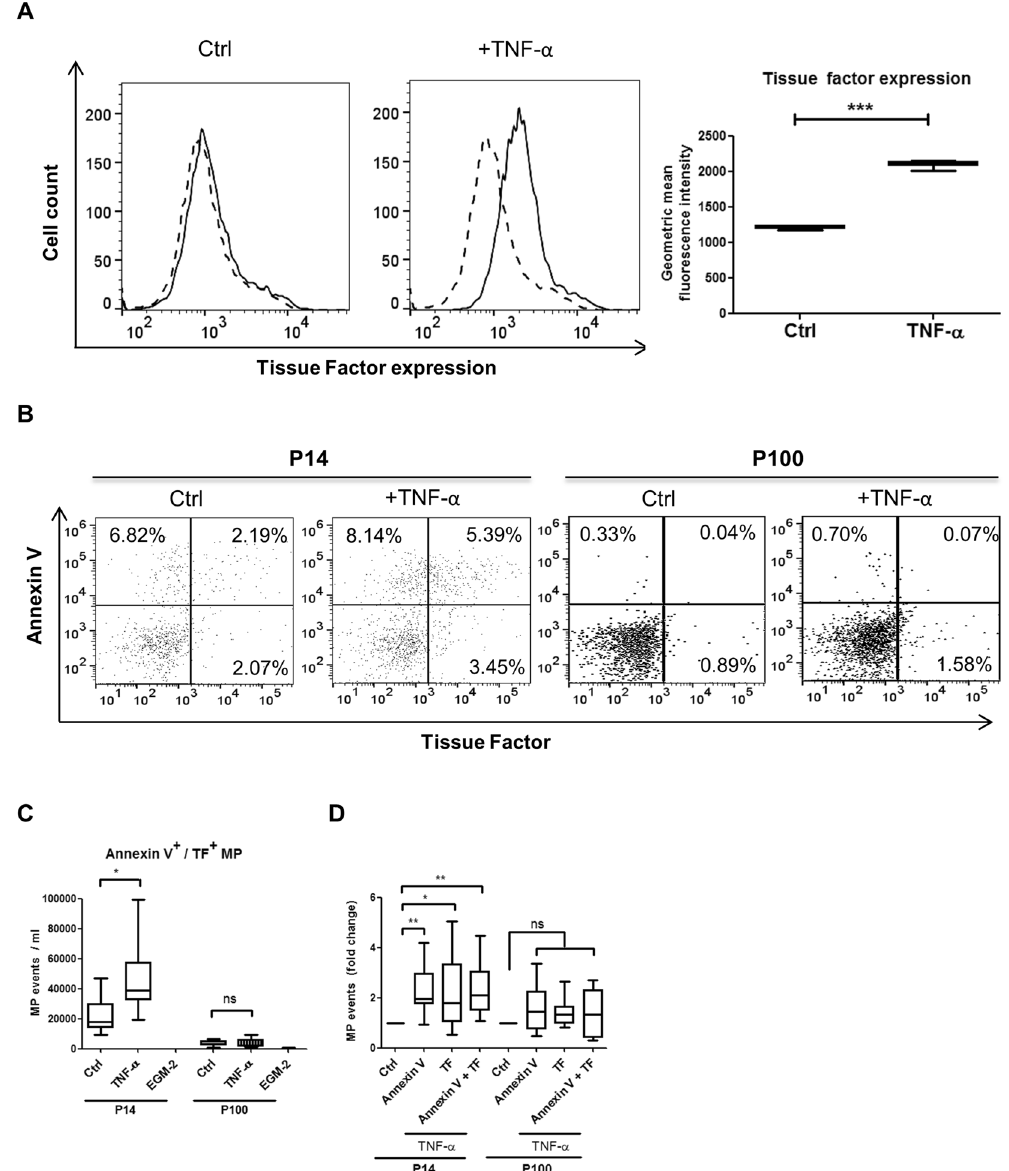
Figure 2. Characterisation of endothelial EVs by flow cyometry and nanoparticle tracking analysis. TF expression on the cell surface is increased upon stimulation of HUVEC with 10 ng/ml TNF- α as measured by flow cytometry; n = 6 ( A ). Representative flow cytometric dot plots of Annexin V + /TF + EVs obtained from processed HUVEC culture supernatants are shown. TNF- α stimulation increased the number of Annexin V + / TF + events in P14 while this effect could not be observed in P100 ( B ). Quantification of flow cytometry data reveals a significant increase in Annexin V + /TF + particle numbers in P14 after stimulation with TNF- α while no significant differences in P100 could be found. EGM-2 was incubated without cells to serve as a negative control and did not contain any Annexin V + /TF + particles in neither fraction ( C ). Fold change analyses of single- and double-positive fractions show that Annexin V + , TF + and Annexin V + /TF + particles in P14 are significantly increased after TNF- α stimulation while there is no significant difference in any fraction of P100 ( D ). n = 6 ( A ); n = 9 ( C , D ); Ctrl = control (non TNF- α –stimulated samples); P14 = pellet containing larger EVs; P100 = pellet containing smaller EVs; EGM-2 = endothelial growth medium-2. ns = not significant; * p < 0.05; ** < 0.01; *** p <